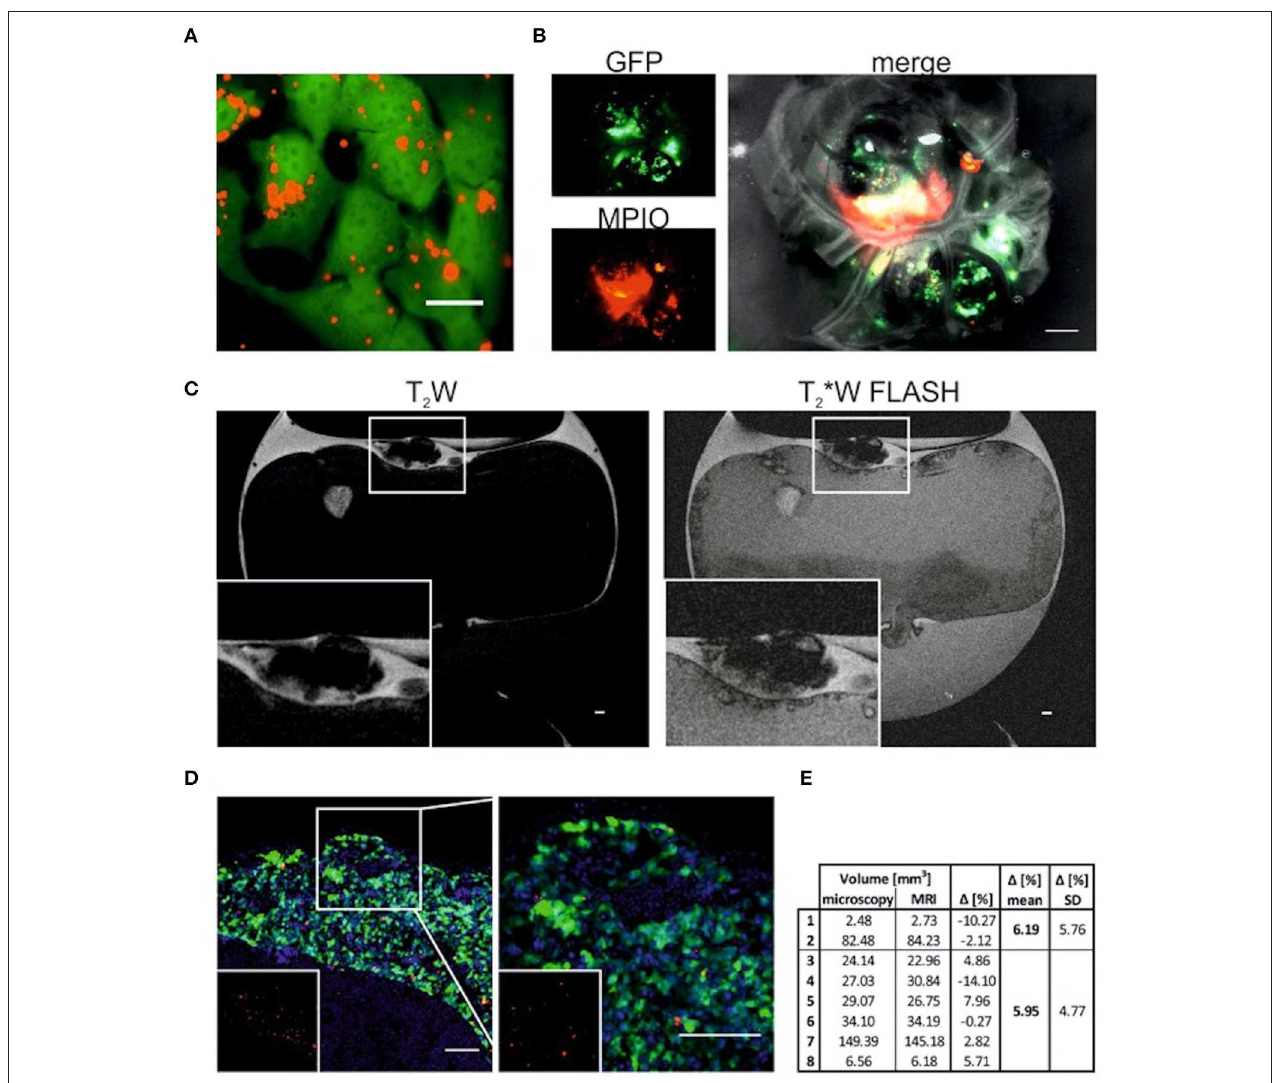
FIGURE 8 | T2W and T2*W FLASH images of tumors labeled with MPIO (A) GFP-expressing SK-N-AS cells (green) 24h -postlabeling with 20mM MPIO (Suncoast Yellow Encapsulated Magnetic Polymers—Bangs Beads, Red). Scale bar is 20mm. (B) Single channel and overlay image of neuroblastoma tumor postdissection formed by GFP-expressing SK-N-AS cells (green) which were labeled with MPIO (red) 48h prior CAM implantation. Scale bar is 1000mm. (C) Representative sagittal T2Wand T2*W FLASH MRI images of embryonated chicken egg at E14 (A) . Tumor formed by cells labeled with MPIO can be identified on top of the CAM (zoom in inset). Scale bar is 1000mm. (D) Representative image of tumor formed on the CAM by GFP-expressing SK-N-AS cells (green) labeled with MPIO (red). Nuclei are stained with Hoechst (blue). Inset shows MPIO only (red). Right image is 2.5_ zoom. Scale bar is 100mm. (E) Comparison of tumor volume (mm3) measured by microscopy or MRI. Tumors 1 to 2 were formed by cells without MPIO, tumors 3 to 8. This research was originally published under the terms of the CC BY license (Creative Commons Attribution 4.0 International License) in Mol Imaging: Magnetic Resonance Imaging for Characterization of a Chick Embryo Model of Cancer Cell Metastases. Herrmann et al.